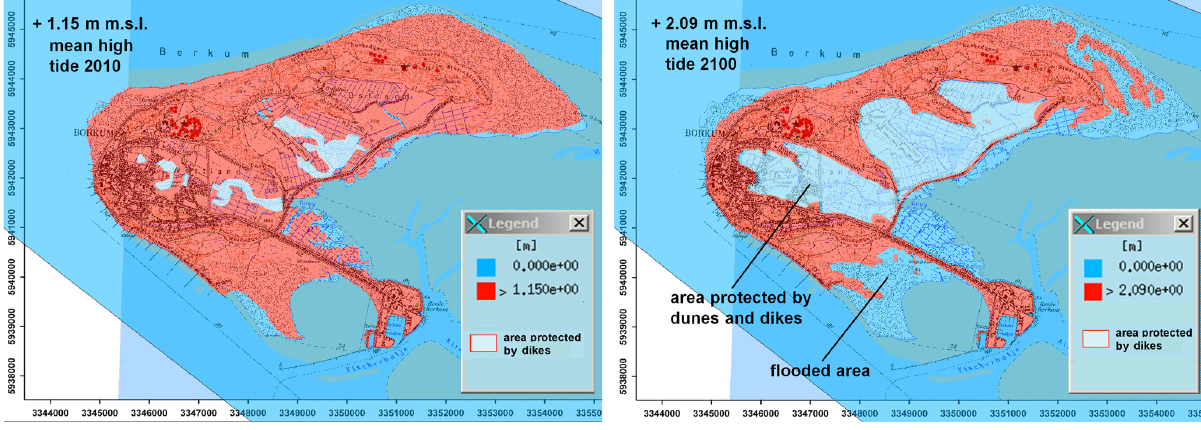
Fig. 17. Left panel: Island of Borkum during mean high tide at present time compared with the simulated A2 scenario for year 2100 (right panel). Blue marked areas are flooded permanently by the tide, hatched blue areas correspond to domains protected from flooding by dunes and dikes being higher than mean high tidal level (red area). The result is that the mean high tide is 0.94m higher and thereby flooding about 25% of the